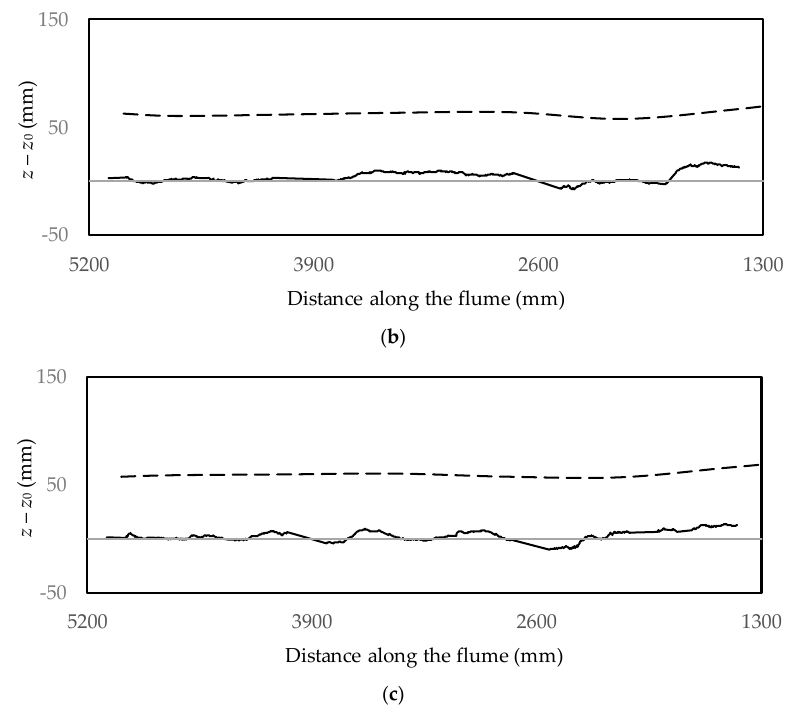
Figure 15. Longitudinal profiles of the water surface (dashed) and bed elevation (continuous) at ( a ) 70 s, ( b ) 80 s, and ( c ) 90 s from the beginning of sediment feeding for the sample experiment. The original bed elevation z 0 is indicated by the gray line. Note the flow from right to left, consistently with Figure 10, 11 and 13.